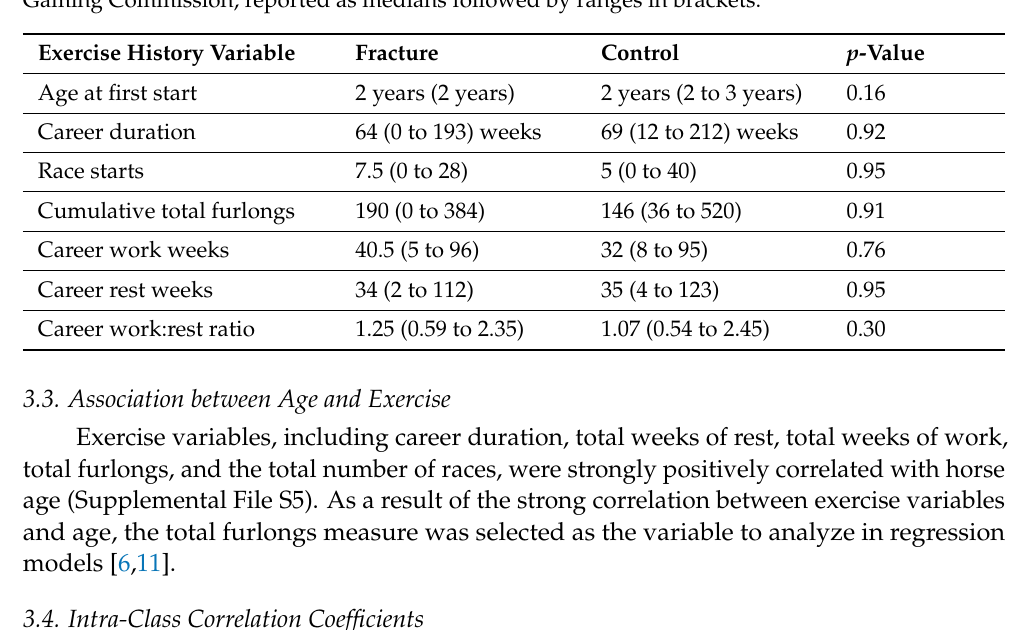
Table 1. Exercise variables acquired for fracture and control cases as provided by the New York State Gaming Commission, reported as medians followed by ranges in